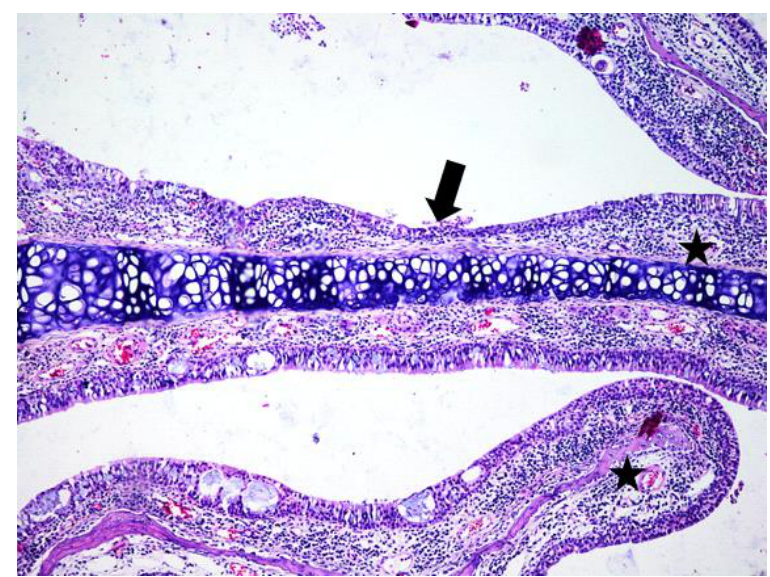
Figure 8. Light micrographs of the rat’s nasal septum, astaxanthin group, at 28 days after the intranasal intervention. Diffusely the lamina propria of the mucosa covering both the nasal septum and nasal conchae is expanded by many lymphocytes admixed with macrophages, few plasma cells (black star) and edema. The covering mucosa is focally excavated (arrow) and covered by squamoid epithelium; H&E, ob × 10.